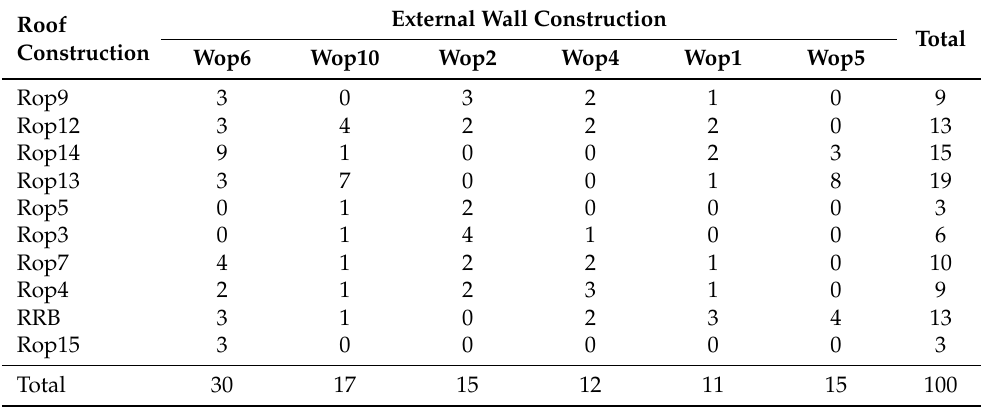
Figure 4. Optimization analysis result at Pareto’s front for the H060 operating in AC mode. Table 5. Resulting counts of each layout combination that appeared at Pareto’s front for the 60 m 2